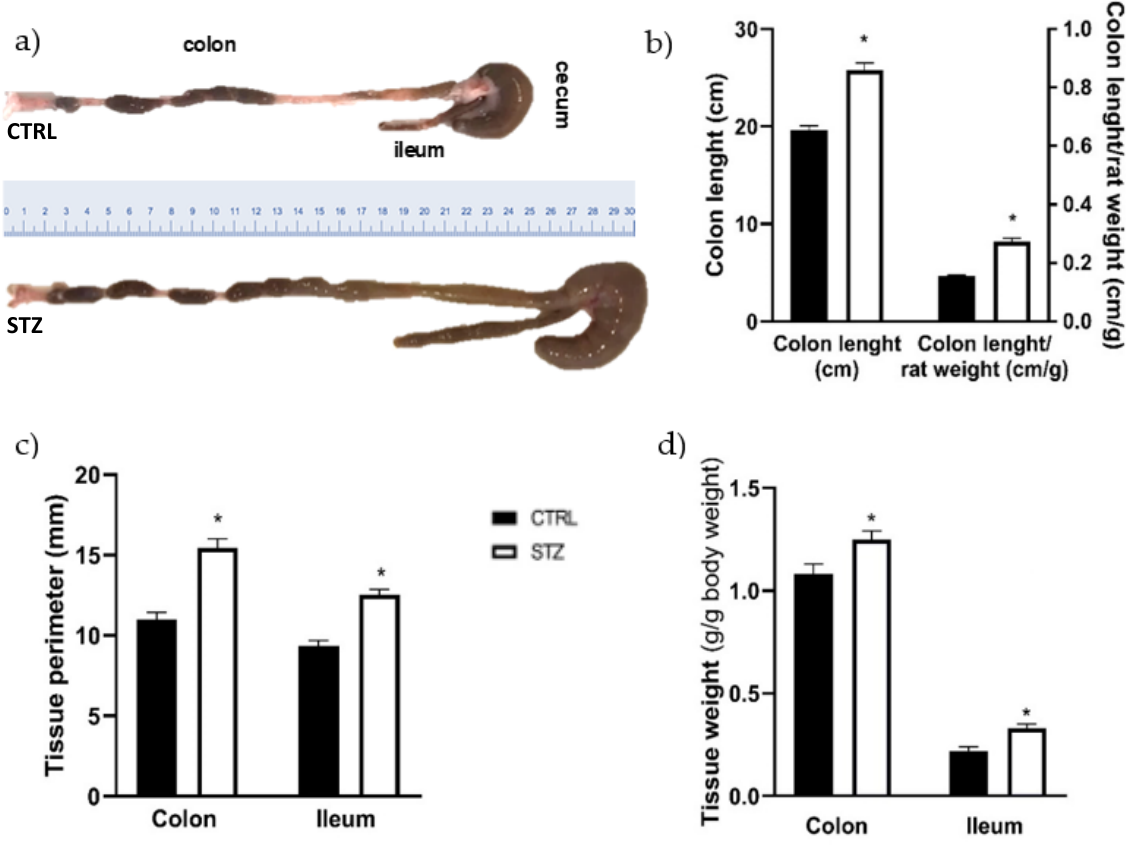
Figure 2. Macroscopic evaluation of the ileum and colon of control (CTRL, black bars, n = 8–12) and streptozotocin-induced diabetic rats (STZ, white bars, n = 11–14): ( a ) representative images of the colon length; ( b ) quantitative analysis of colon length (left y axis) and colon length per rat weight (right y axis); ( c ) tissue circumferential perimeter of the colon and ileum and ( d ) relative weight of intestinal segments (without fecal content) expressed as g of colon or ileum/g of body weight. Values are mean ± SEM and unpaired student’s t test was used to compare the two experimental groups (CTRL and STZ). * Statistical difference, p < 0.05.